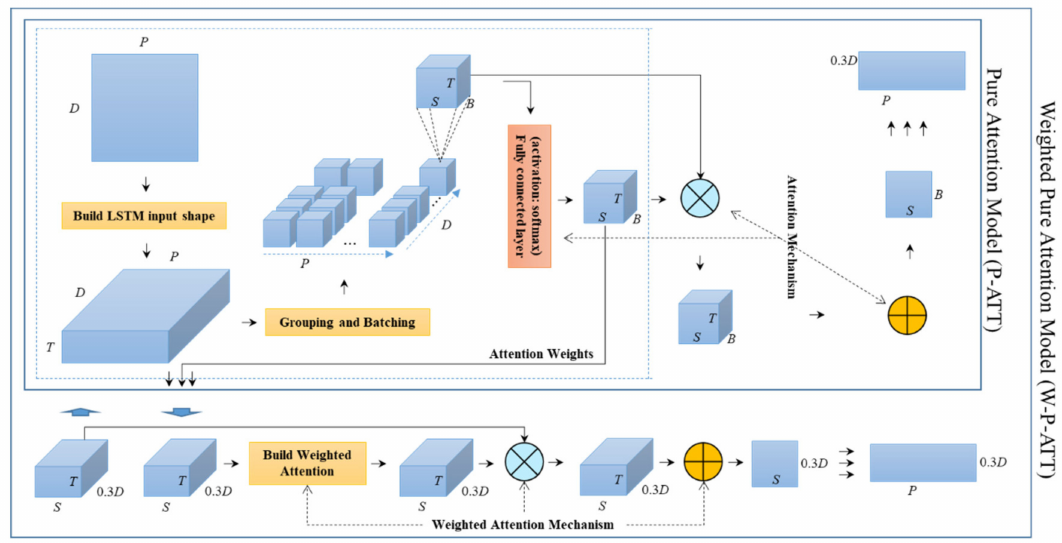
Figure 4. The structure of the P-W-ATT